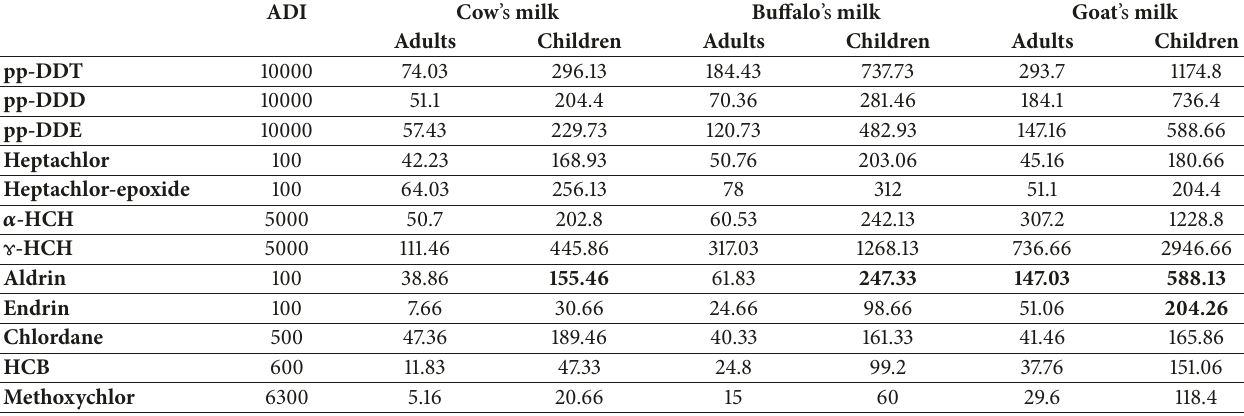
Table 1: Estimated daily intake of OCPs due to ingestion of milk among Egyptian population.